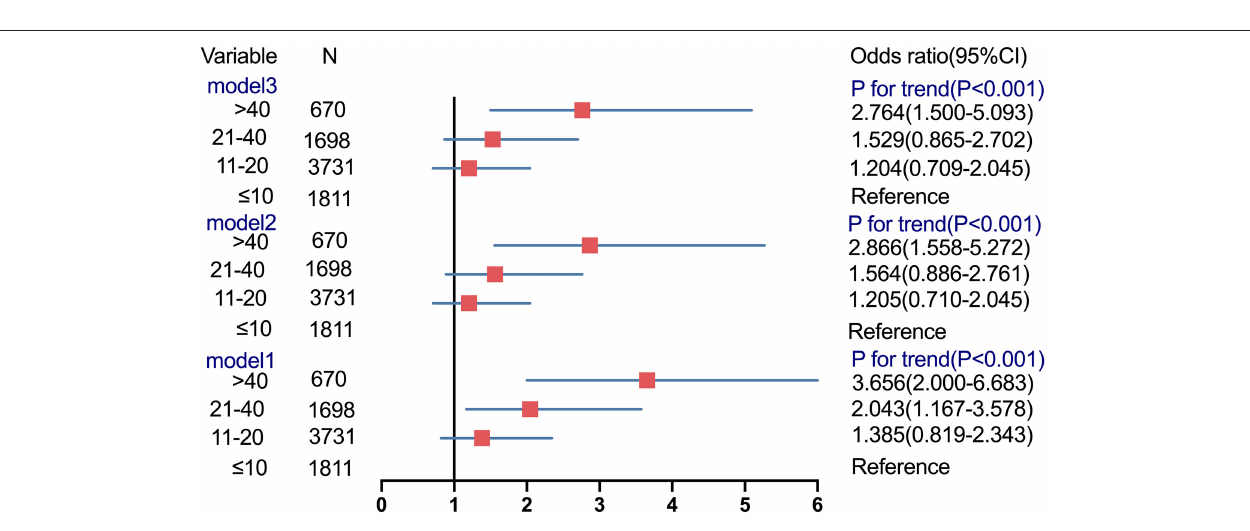
promote the liver to release more maternal-derived cfDNA. Moreover, we added HBV infection to the above Model 3 and found that HBV infection did not affect the NIPS test failure